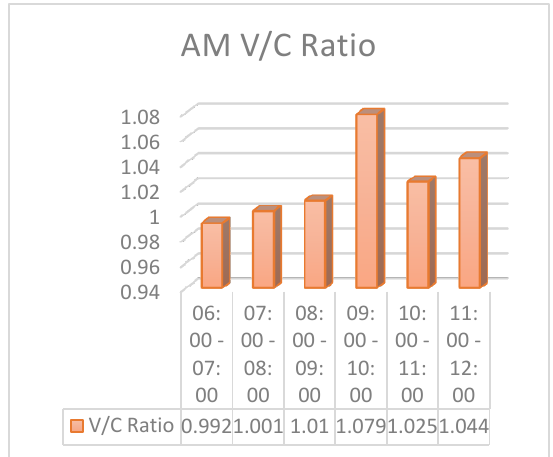
Figure 11: Morning (am) level of congestion